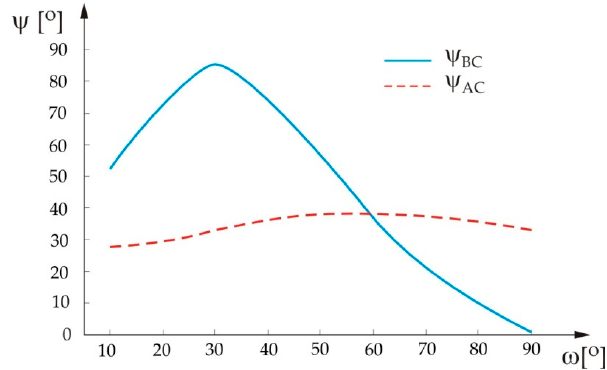
Figure 4. Variation of the mode mixities ψ BC and ψ AC in terms of angle ω .